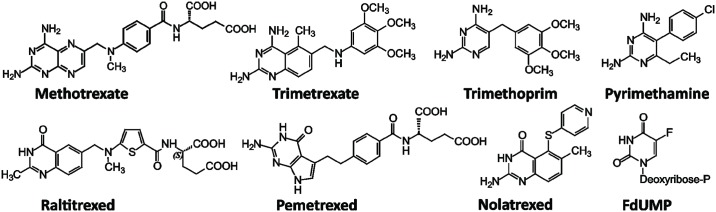
Chemical structures of DHFR and TS inhibitors.